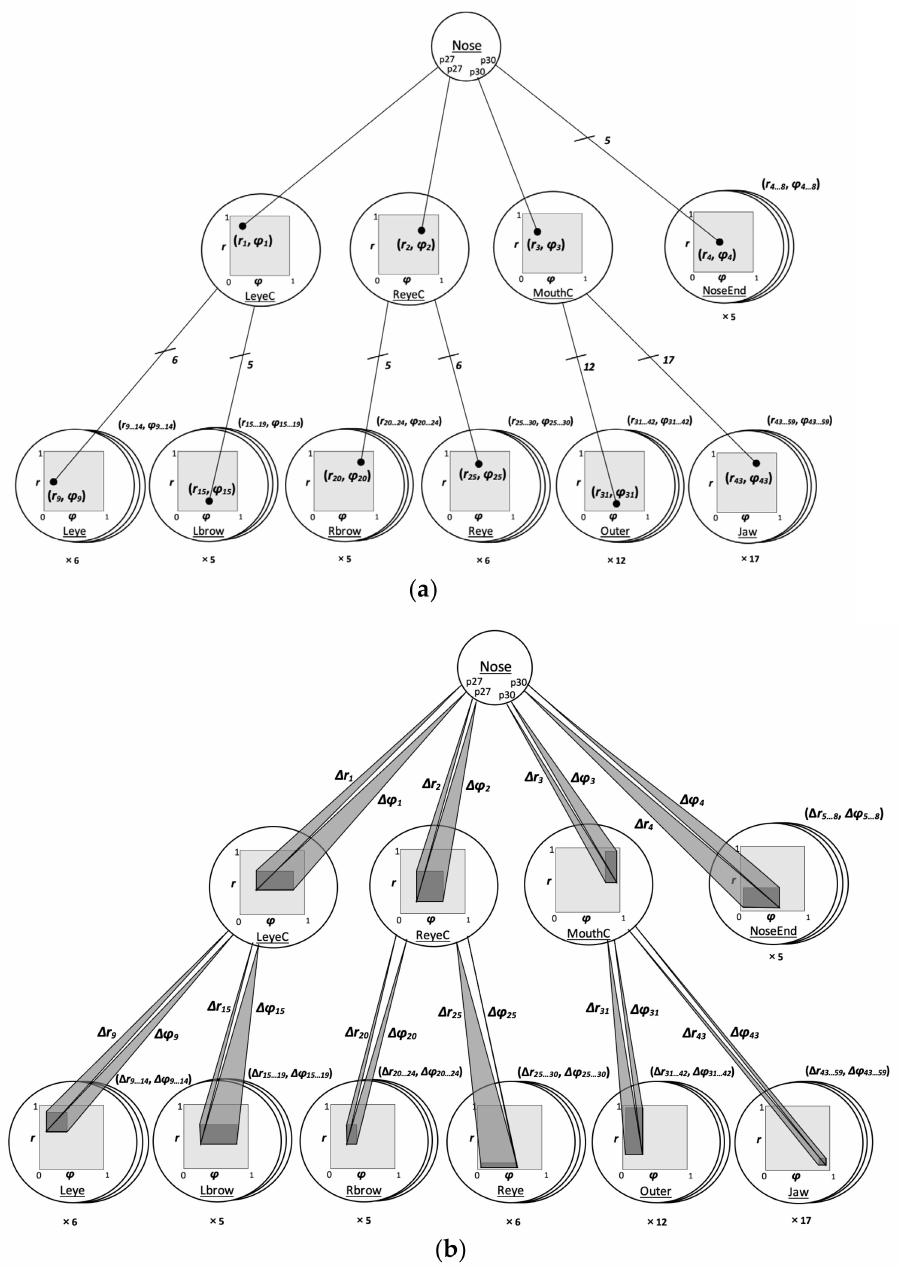
Figure 6. ( a ) A trivial-tree represents a single head orientation image frame. ( b ) An interval-tree represents a neighborhood of trivial-trees; in other words, an interval-tree represents an information granule or, equivalently, a grove of trivial